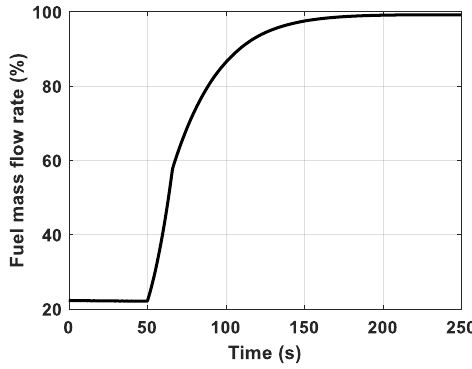
Figure 5. Fuel mass flow rate time variation.